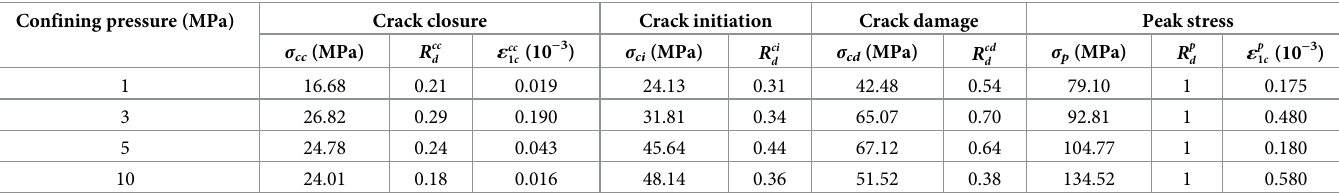
Table 4. Stress thresholds, stress–strength ratio R d and characteristic axial crack strain.